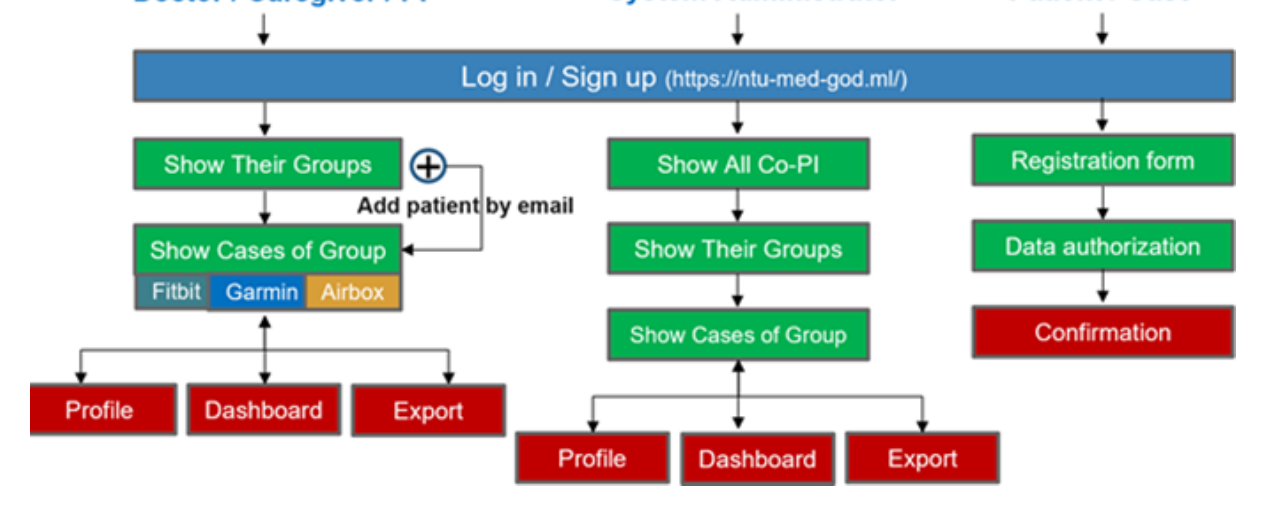
Figure 5. Screenshots of NTU-med-good health advice